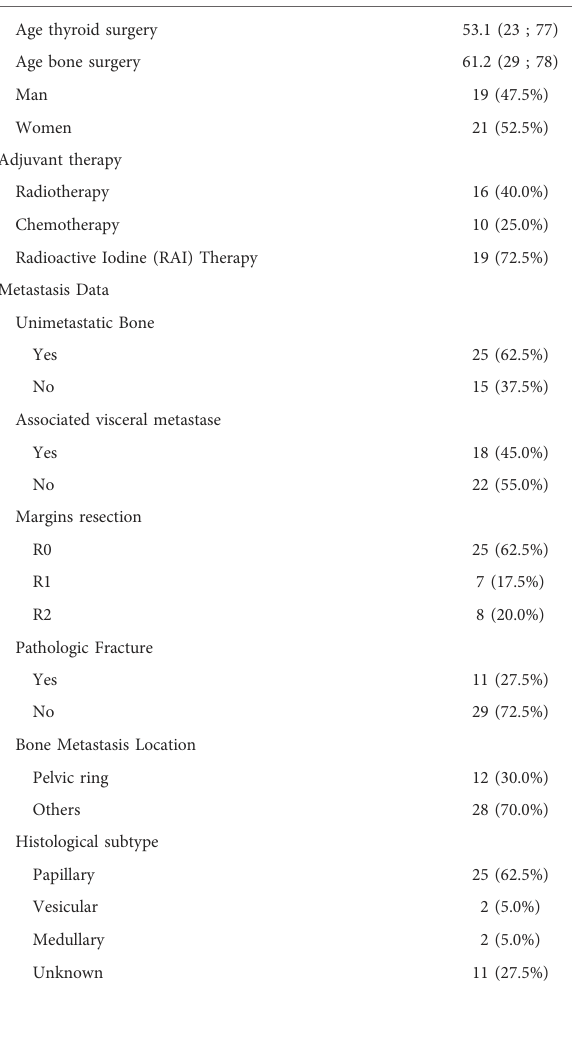
TABLE 1 Study population